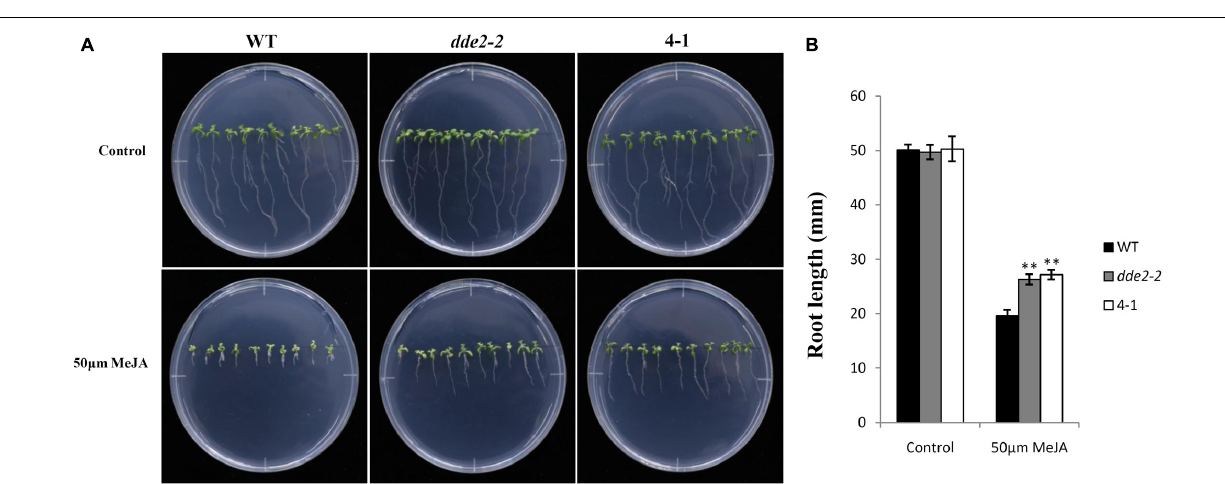
FIGURE 8 | Sensitivity analysis of wild-type, transgenic line 4-1 and JA-insensitive mutant dde2-2 in response to methyl jasmonate (MeJA). (A) 12-day-old seedlings were grown on agar plates supplemented with (50 µ M MeJA) or without (Control) MeJA. (B) Measurement of the root length in wild-type, 4-1 and dde2-2 grown for 12 days on agar plates held upright and containing or not containing 50 µ M MeJA. Data are mean of at least 20 roots; error bars represent the standard deviation of 20 biological replicates; ∗∗ P < 0.01 relative to the wild-type, using Student’s t